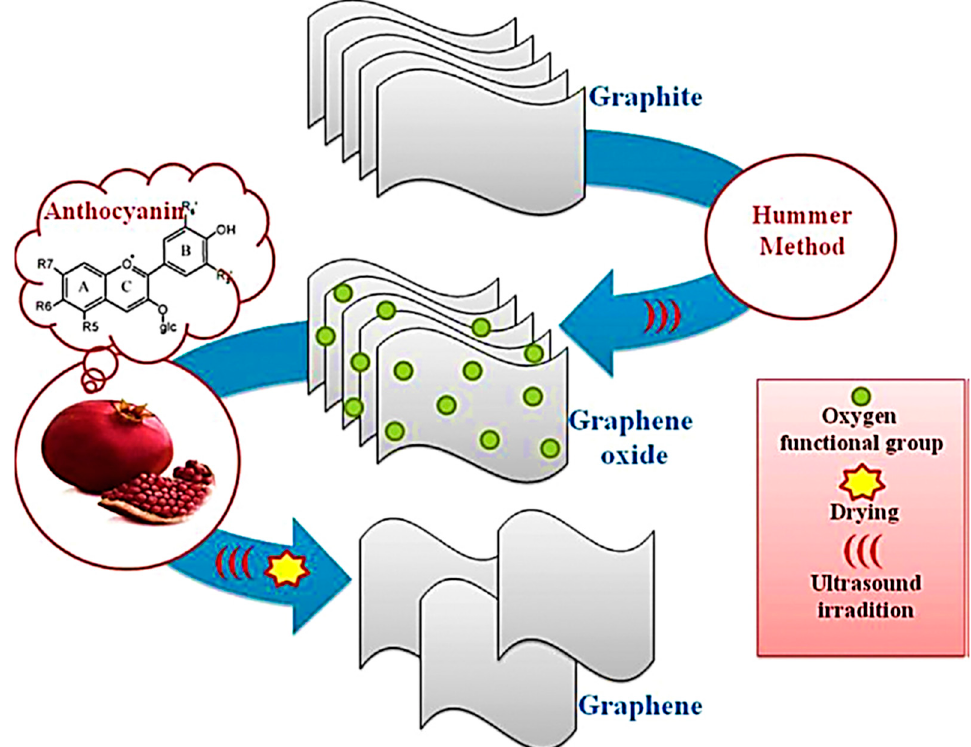
Figure 5. Mechanism of forming graphene nanosheets by using pomegranate via a green route [83]. Reproduced with permission from Elsevier.